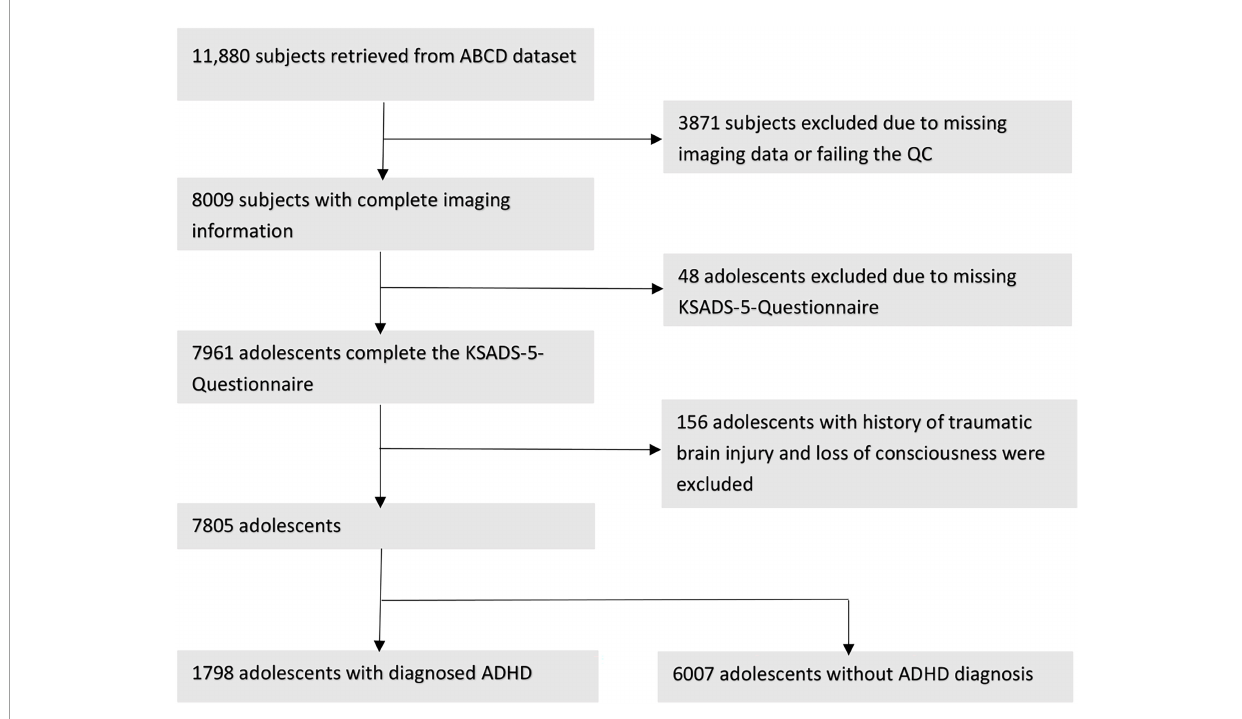
FIGURE1 Workflow after we proceed to extract our cohorts regarding to the exclusion criteria and showing the remain subjects.